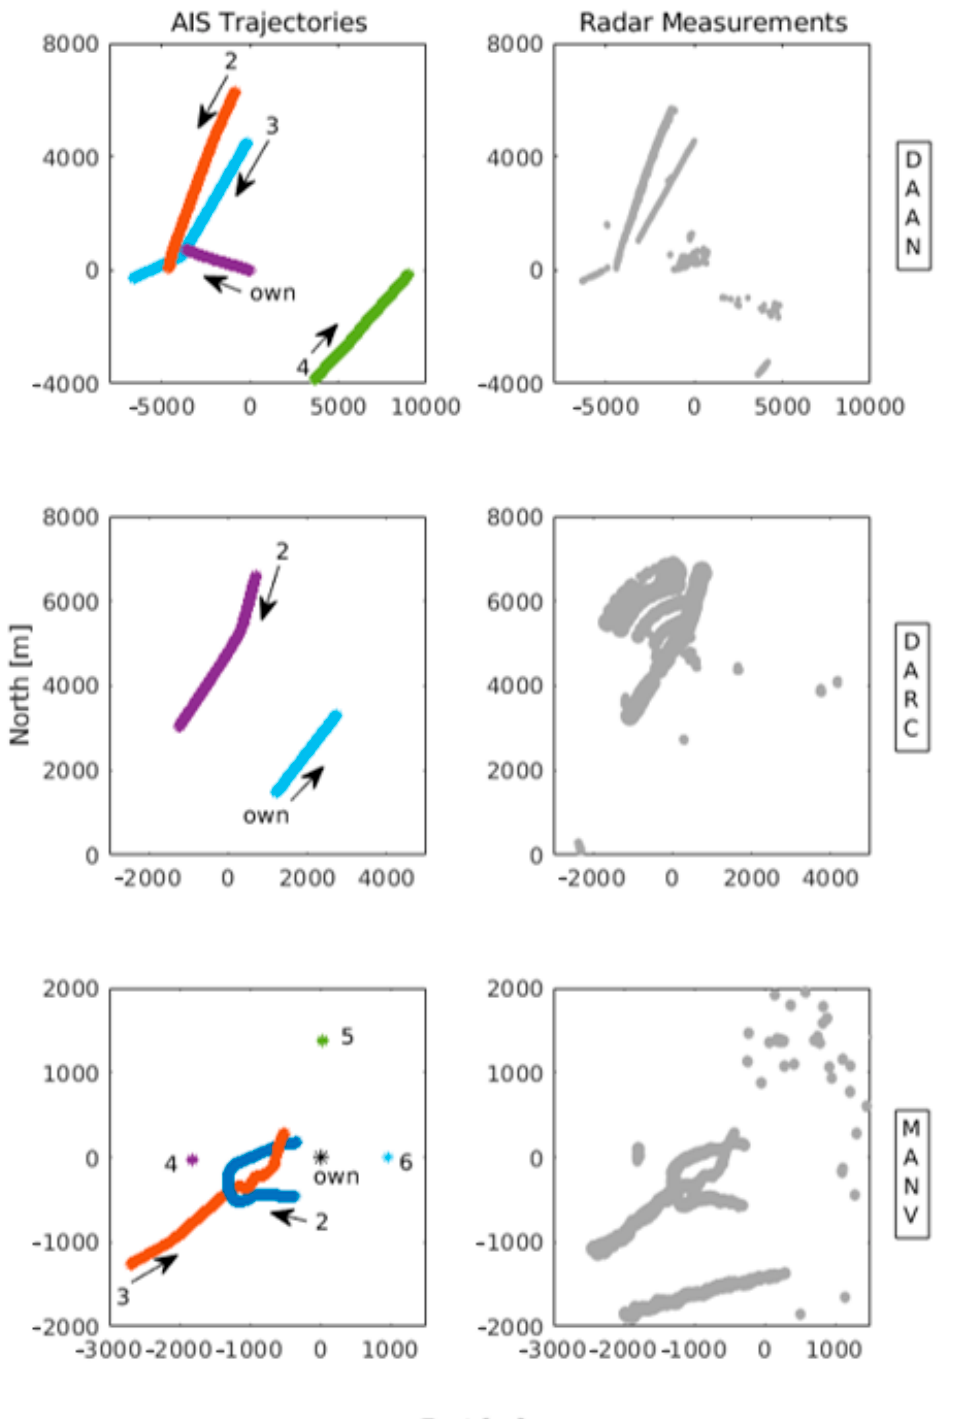
Figure 2. Depiction of the datasets’ trajectories. The left column shows the AIS-based reference trajectories of vessels for each dataset, all labelled. The arrows indicate the course of the vessels. The right column shows the radar point clouds measurements. Notice the trails of radar reflections in DAAN ( Data Association with Aids to Navigation ), the radar beacon (RACON)-originated measure- ments in DARC ( Data Association with RACON ) and the aids to navigation. In MANV ( Manoeuvres ), an unknown target has also been detected.